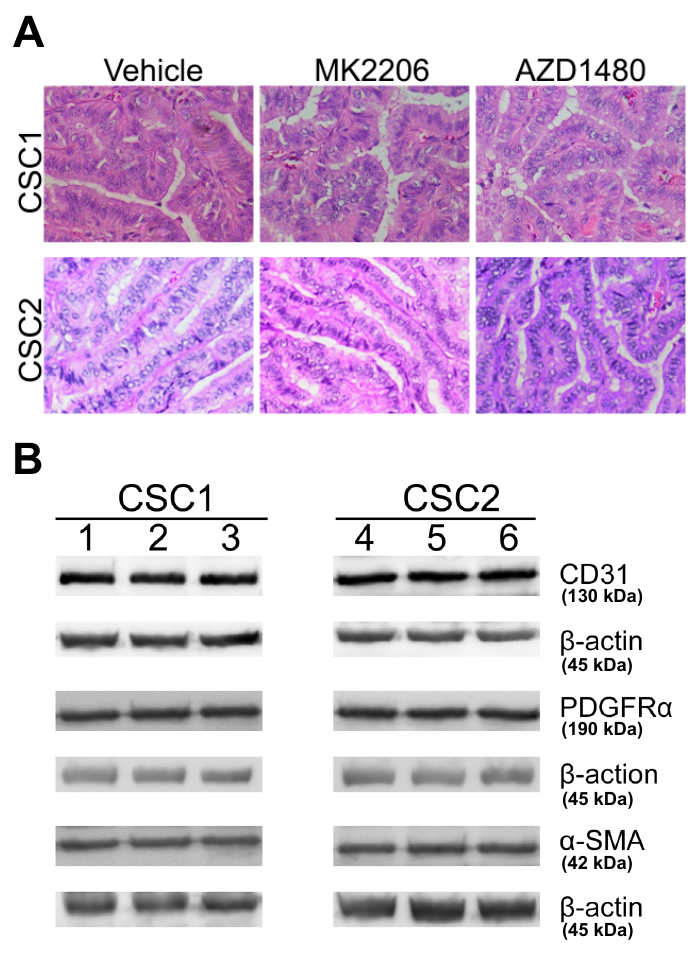
Figure 7. Inhibition of PI3K/Akt and JAK/STAT3 signaling had no detectable influence on tumor histology and the expression of the fibroblast and vasculature genes. ( A ) Tumor histology was not altered after MS2206 (middle column) and AZD1480 (right column) treatment compared with the vehicle (left column) treatment. ( B ) Vascular endothelial cell CD31 expression did not show alterations after the MS2206 (lane 2, 5) and AZD1480 (lane 3, 6) treatment compared with the vehicle (lane 1, 4) treatment; cancer-associated fibroblast markers PDGFR- α and α -SMA expression did not show alterations after the MS2206 (lane 2, 5) and the AZD1480 (lane 3, 6) treatment compared with the vehicle (lane 1, 4) treatment. Scale bars: 100 µ